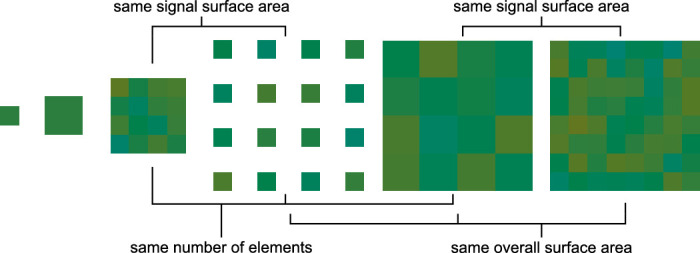
Experimental conditions for Experiment 2. The experiment included six different types of stimuli. The one element stimuli were only tested in the no-noise condition and acted mainly as a control. The other four stimuli were designed to share some of the aspects named in the figure while differing in others: number of elements, signal surface area, and overall surface area. They were presented only in the high-noise condition. Please note that these stimulus examples are shown only for illustration and do not exactly match the stimuli in the experiment. The experimental stimuli were carefully color-calibrated and shown on a gray background.